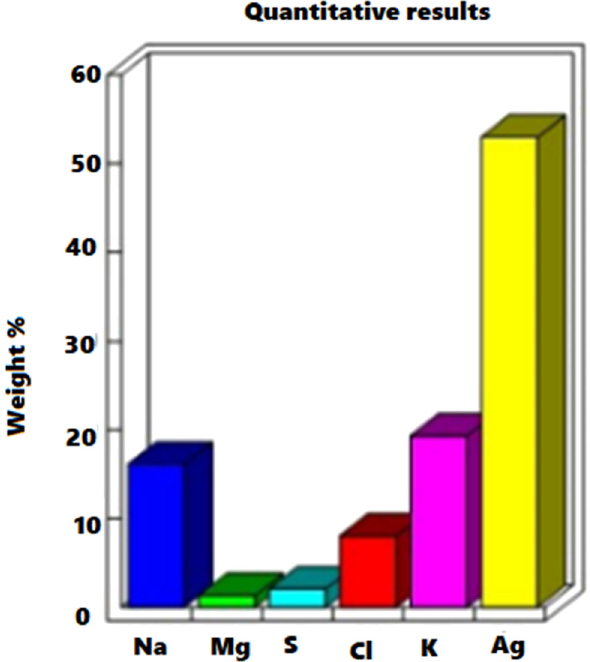
Figure 5: EDX elemental analysis of green - synthesized A. digitata